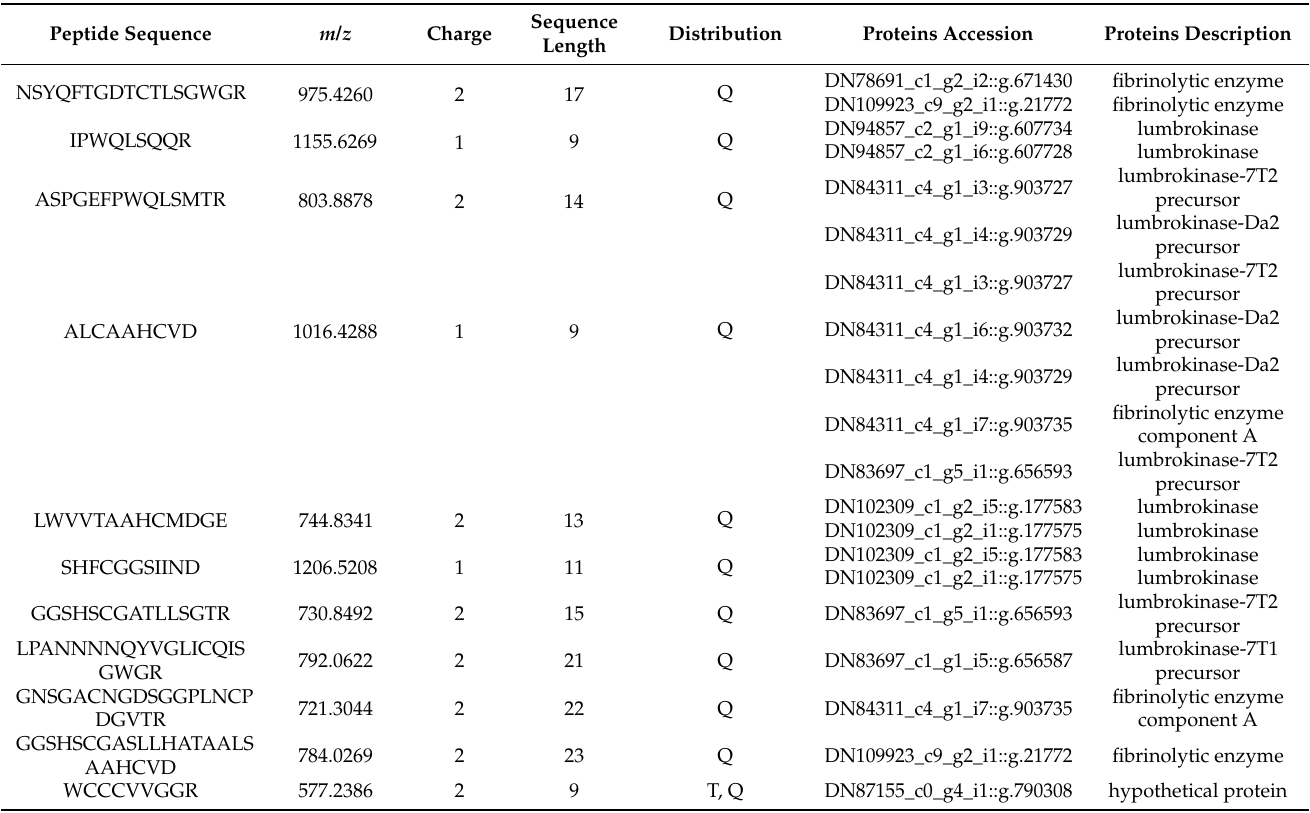
Table 1. Peptide markers associated with thrombolysis efficacy of P. aspergillum